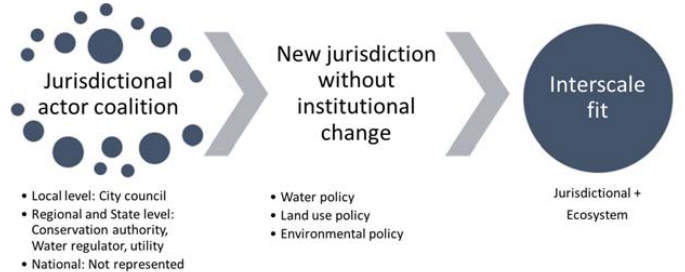
Figure 6. Actors form different coalitions for each adaptation measure that enhances jurisdictional and ecosystem fit. Local and regional level jurisdictions provide plan formulation to integrate their different policies.